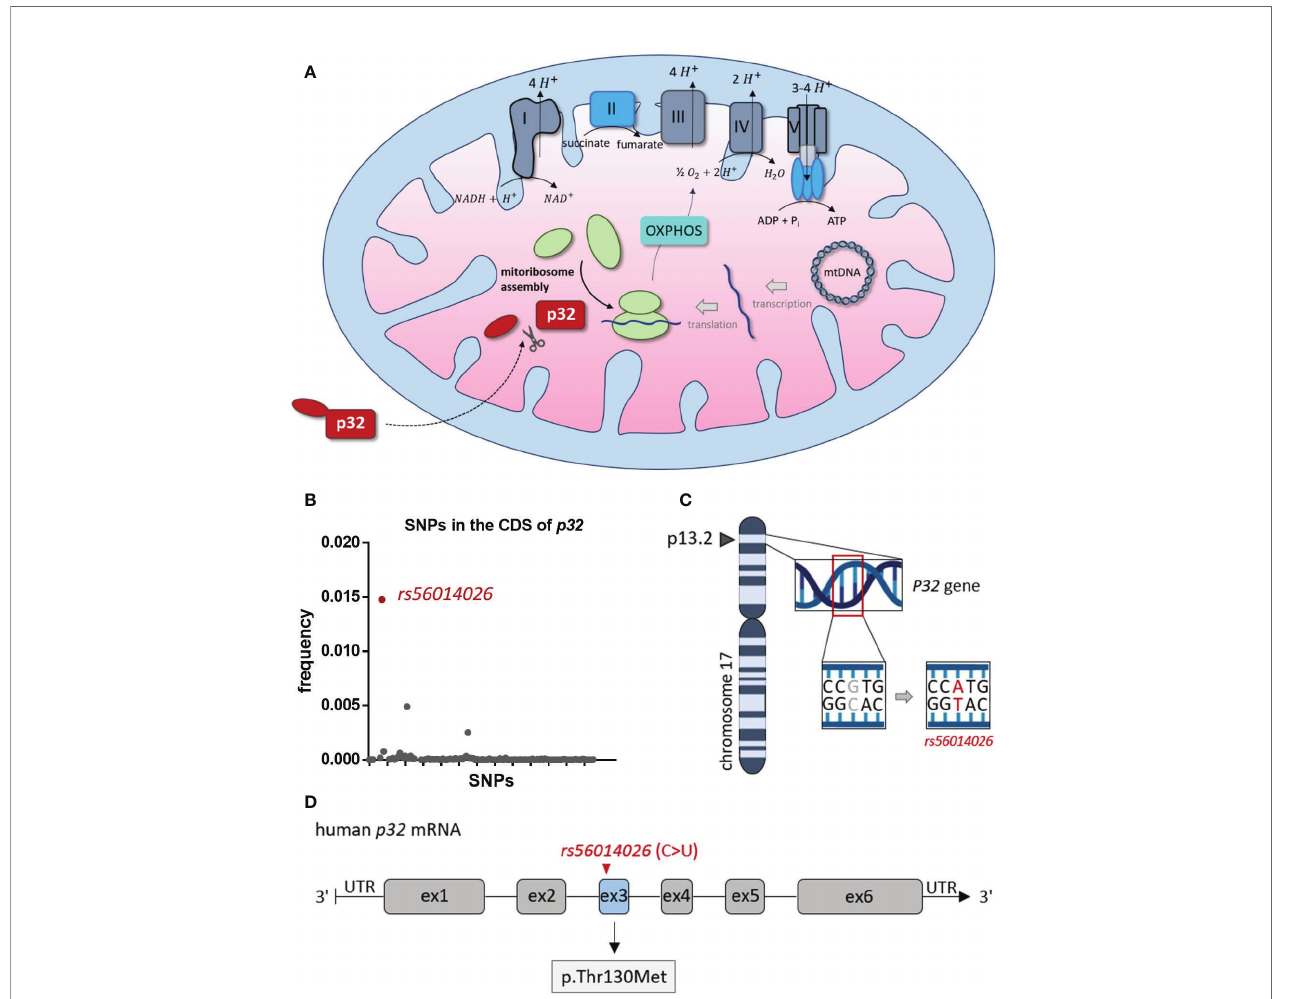
FIGURE 1 | Rs56014026 is the most common SNP in the CDS of P32. (A) Mitochondrial p32 functions in the assembly of the mitoribosome, which makes it essential for translation of the mitochondrially encoded subunits of the complexes I, III, IV and V of the electron transport chain (depicted in grey) [26, 27]. (B) Frequency of SNPs (n=124) located in the coding sequence (CDS) of human P32. Data are based on the SNP database (dbSNP) of the National Center for Biotechnology Information (NCBI). (C) The P32 gene is located at position 13.2 of the short (p) arm of human chromosome 17 (17p13.2). (D) Schematic model of human p32 mRNA (exons 1 – 6). The SNP rs56014026 , leading to substitution of cytosine by uracil (C>U), is localized in exon 3 and results in the missense mutation p.Thr130Met (T130M) in